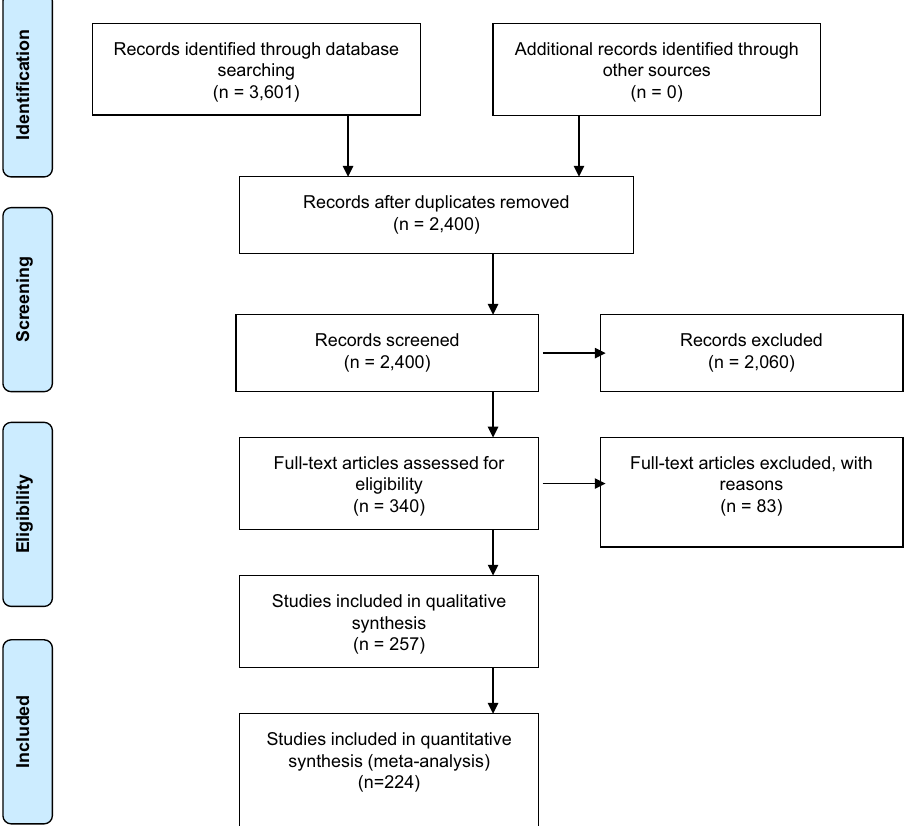
Fig. 9 PRISMA fl ow diagram outlining the systematic review process. The Preferred Reporting Items for Systematic Reviews and Meta- Analyses (PRISMA) Flow Diagram 56 outlines the screening process from the number of publications identi fi ed through the database search to the fi nal number of publications included in the qualitative synthesis that met the a priori inclusion